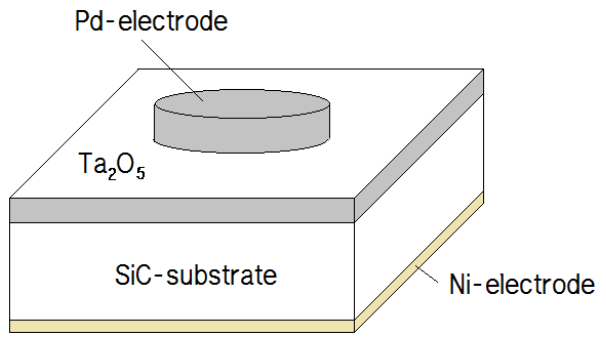
Figure 1. Schematic diagram of the hydrogen